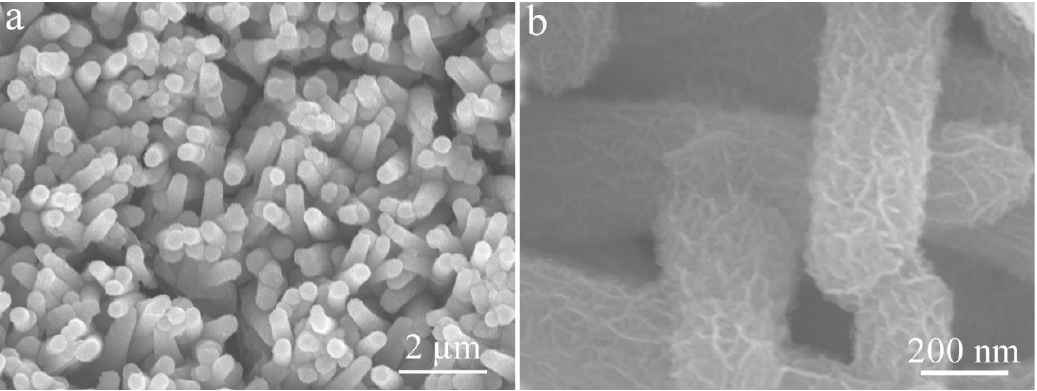
Figure 12. ( a ) Low-magnification and ( b ) high-magnification FE-SEM images of the Cu(OH) 2 /Ni 3 S 2 composite after the electrochemical test.